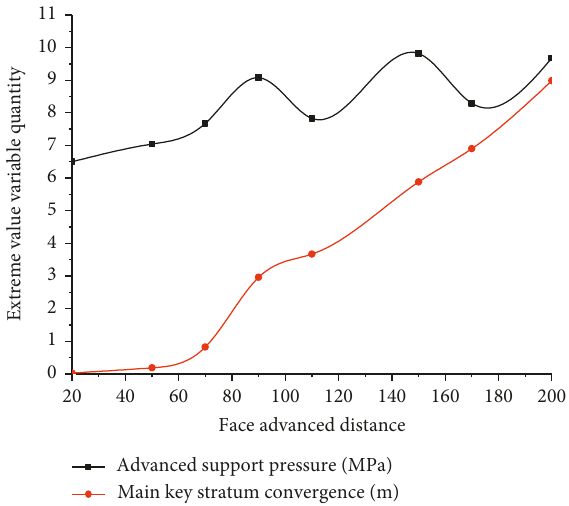
Figure 7: The advanced support pressure and the subsidence of the main key